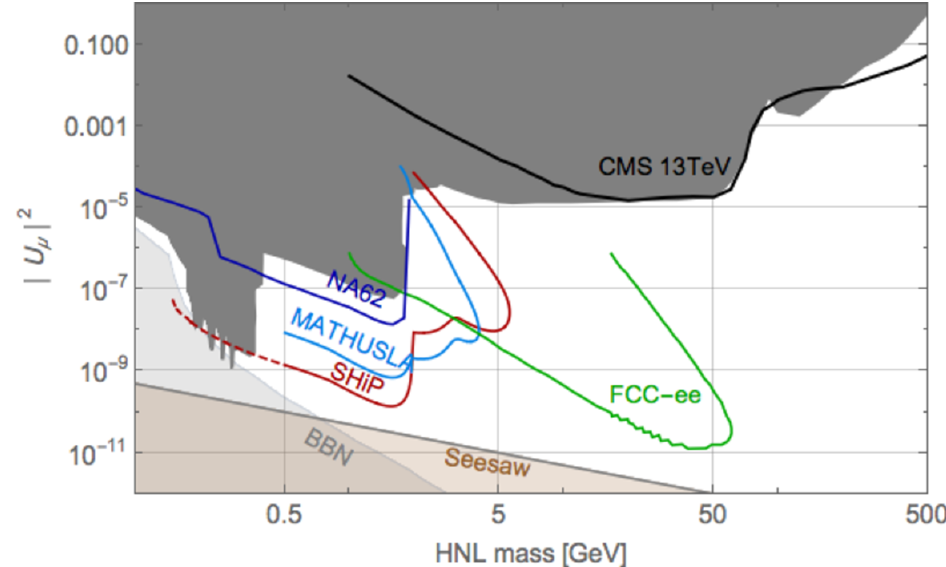
Figure 1 . Existing limits and future prospects for searches for HNLs. Only mixing with muon (cid:13)avour is shown. For the list of previous experiments (gray area) see [5]. Black solid line is the recent bounds from the CMS 13 TeV run [23]. The sensitivity estimates from prospective experiments are based on [27] (FCC-ee), [9] (NA62), [60] (SHiP) and [61] (MATHUSLA@LHC). The sensitivity of SHiP below kaon mass (dashed line) is based on the number of HNLs produced in the decay of D -mesons only and does not take into account contributions from kaon decays, see [60] for details. The primordial nucleosynthesis bounds on HNL lifetime are from [62]. The Seesaw line indicates 2 the parameters obeying the seesaw relation U (cid:22) m (cid:23) =M N , where for active neutrino mass we j j (cid:24) p substitute m (cid:23) = (cid:1) m 2 0 : 05 eV [5]. atm (cid:25)